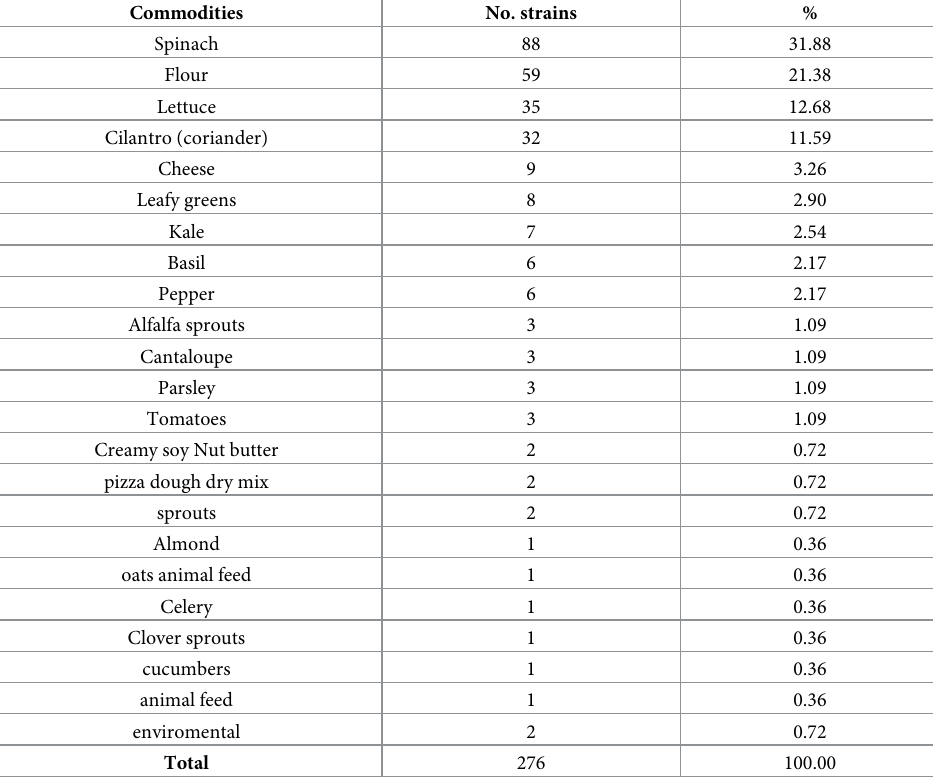
The stx -negative strains were eliminated from this